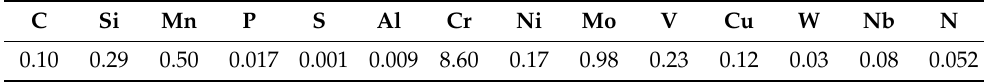
Table 1. Chemical composition (wt %) of the base material, SA 355 P91 steel.